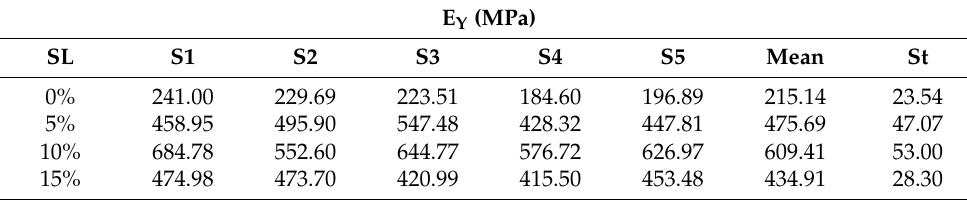
Table 4. Secant modulus (MPa) for Y